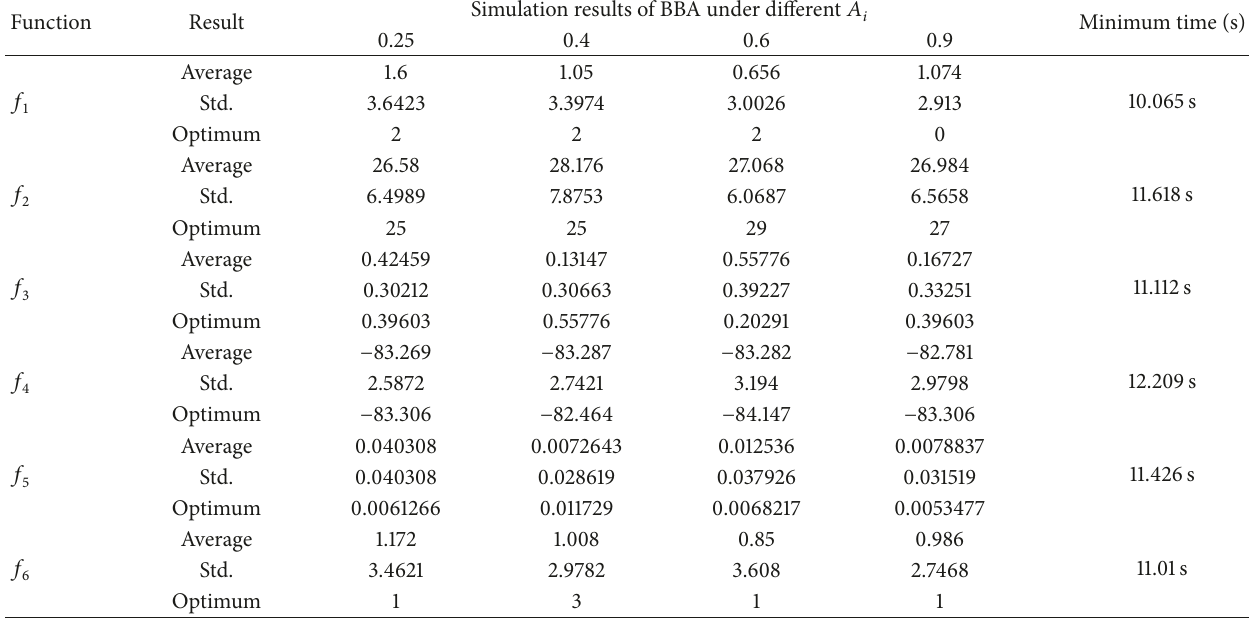
Table 2: Performance comparison of BBA under different 𝐴 𝑖